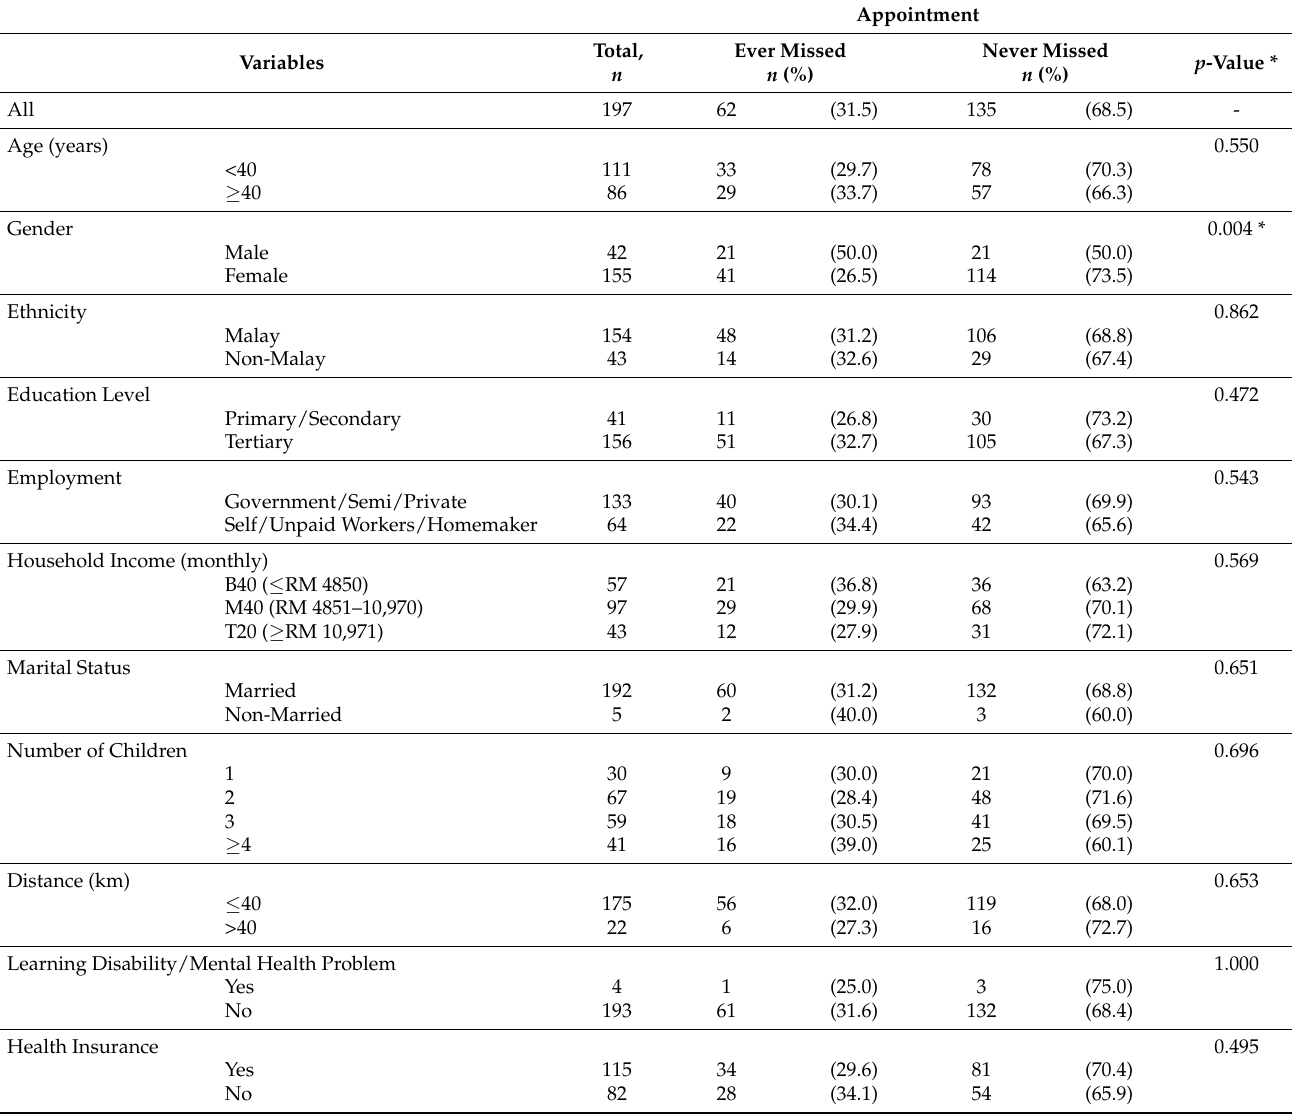
Table 5. Differences in missed appointment rates by sociodemographic and characteristics of care- givers in the study ( n =